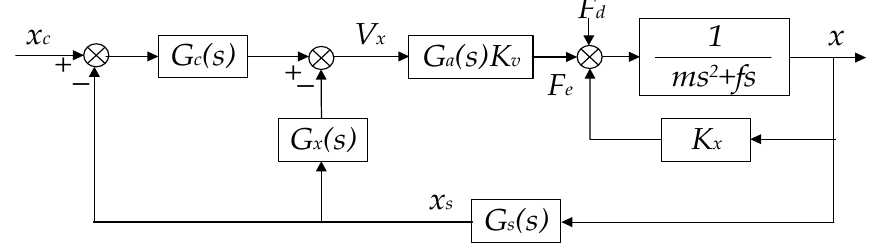
Figure 7. Block diagram of the electrostatic suspension system with feedforward compensation.